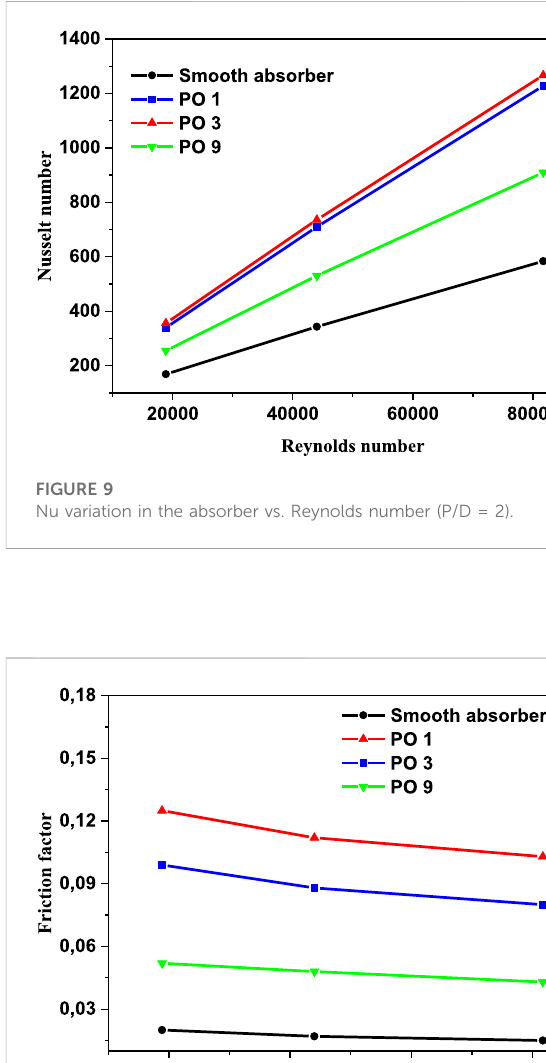
FIGURE 7 Nussle number with Gnielinski correlation.